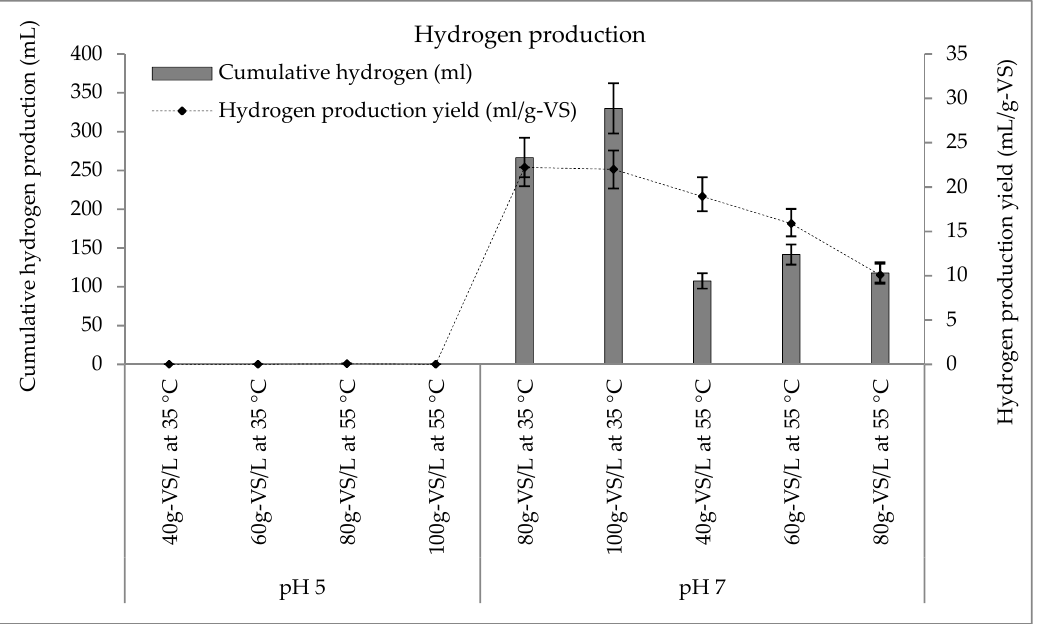
Figure 3. Cumulative hydrogen and hydrogen production yields from initial pH of 7 and 5 at different initial concentrations (40-100 g-VS/L) and temperature (35 and 55 °C).